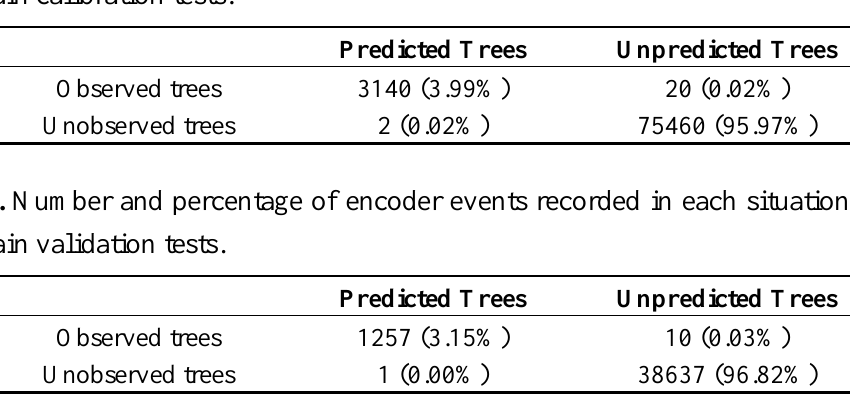
Table 12. Number and percentage of encoder events recorded in each situation during the light curtain calibration tests.